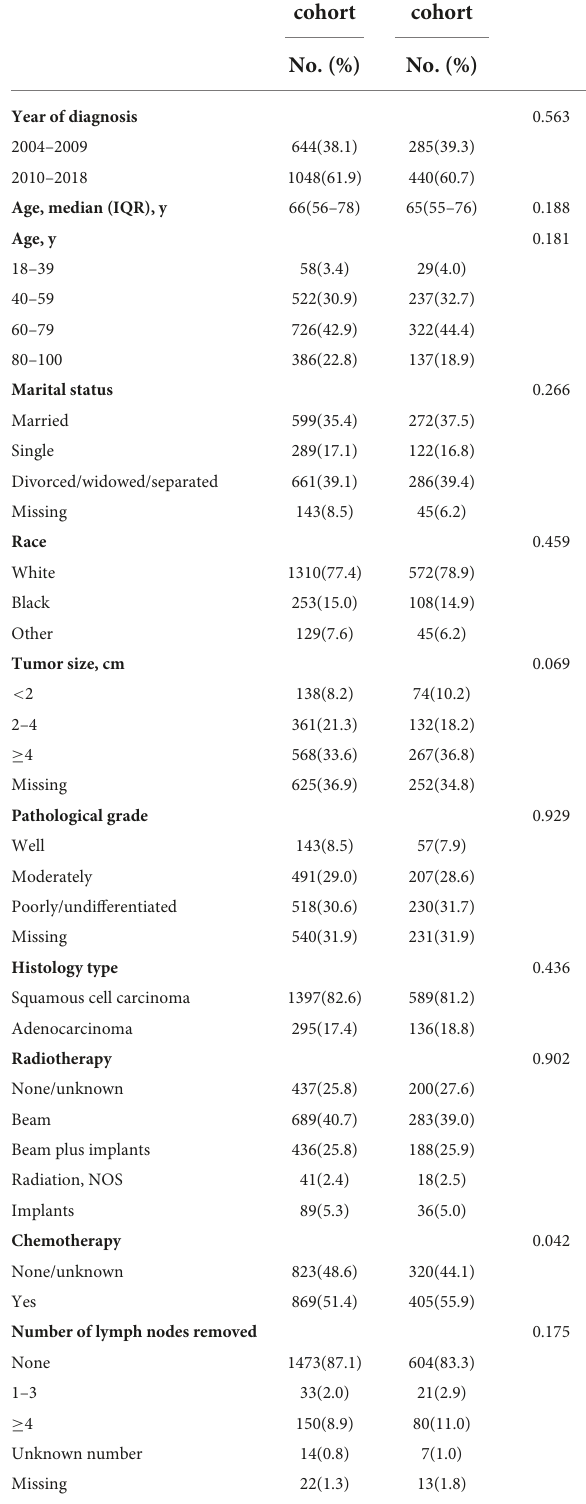
TABLE 1 Composition proportion of each baseline characteristic in the training and validation cohorts derived from the final selected vaginal cancer patients diagnosed between 2004 and